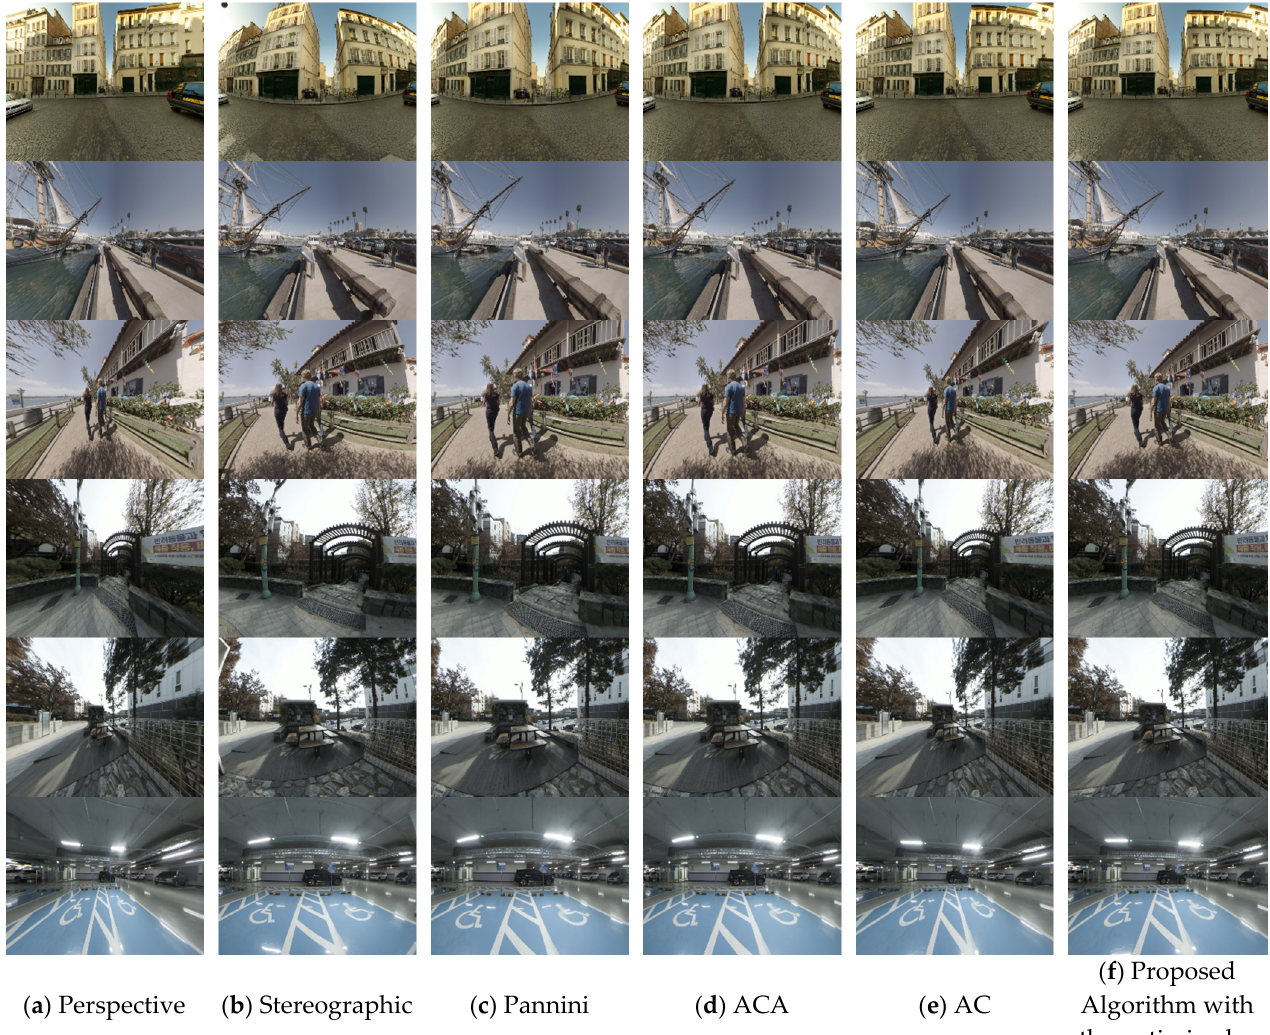
Figure 18. Viewport images produced by various projection techniques for the equirectangular test images of Figure 17.